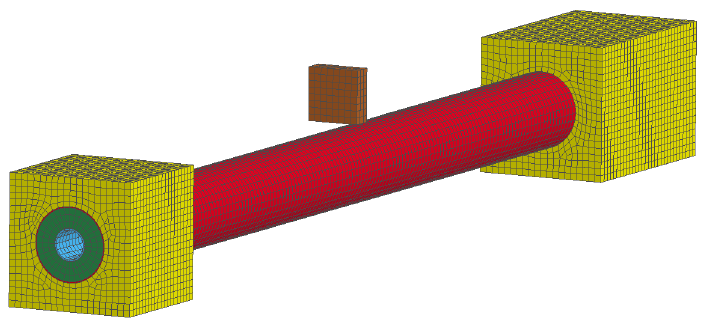
Figure 3. Schematic diagram of finite element model.